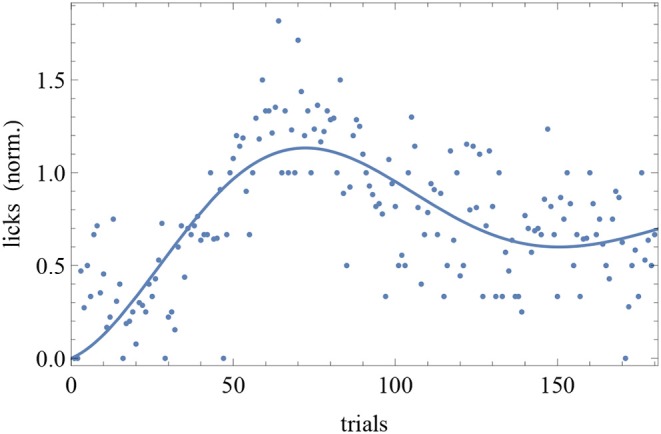
Trial-by-trial data of subject CR10-1 fitted with the DOM (8). Trials are on the horizontal axis and response is on the vertical axis.